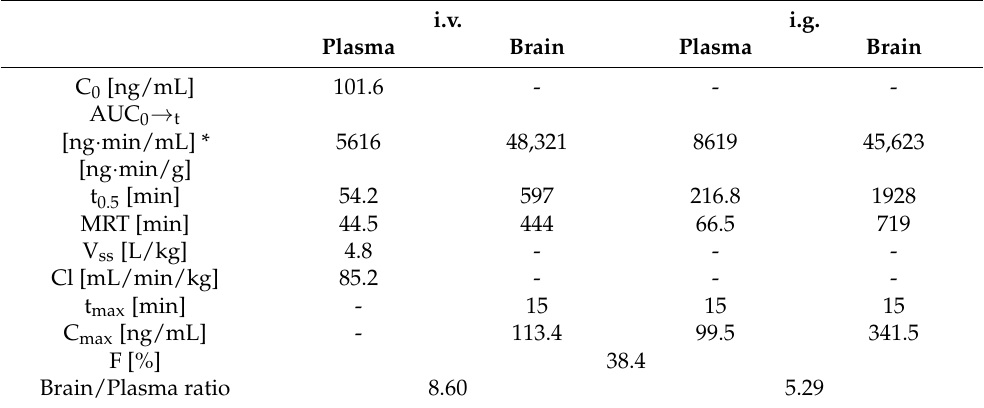
Table 3. Pharmacokinetic parameters and brain uptake for PQA-AZ6 after i.v. and i.g. administration at a dose of 0.5 and 2 mg/kg to male rats,